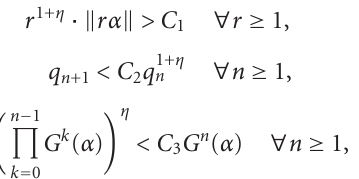
Figure 1.1. r ·(cid:10) rα (cid:10) versus r for α = (